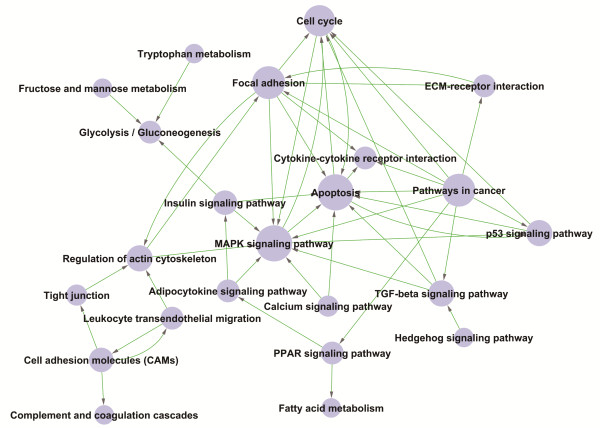
Significant pathways involving differential genes by path-net construction. The Path-Net depicted the interactions between the significant pathways of the differentially expressed genes, and was built according to the interactions with pathways in the KEGG database directly and systemically. Cycle nodes represent pathways, the size of nodes represents the power of the interrelation among the pathways, and an arrow between two nodes represents an interaction target between pathways. The more edges of a pathway, the more pathways connecting to it, and the more central role it has within the network.